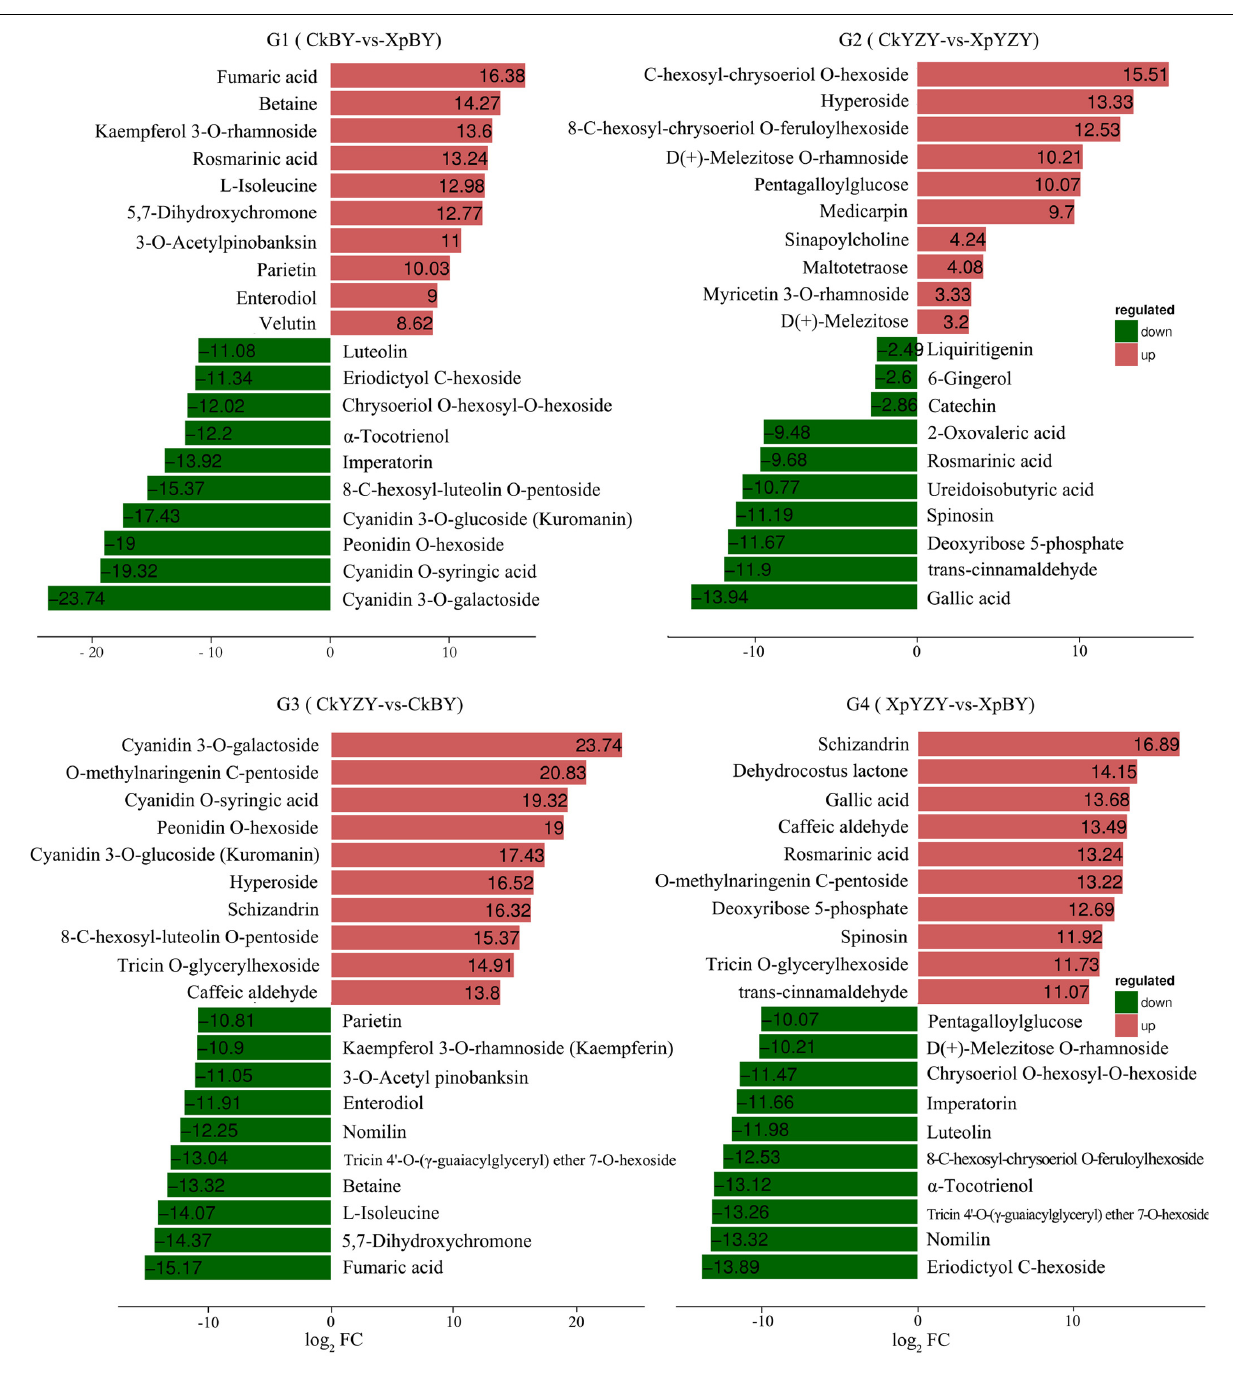
FIGURE 8 | K -means figure of the top 10 differential metabolites (G 1 ) log 2 FC (XpBY–CkBY), (G 2 ) log 2 FC (XpYZY–CkYZY), (G 3 ) log 2 FC (CkBY–CkYZY), and (G 2 ) log 2 FC (XpBY–XpYZY). Red denotes upregulation and green denotes